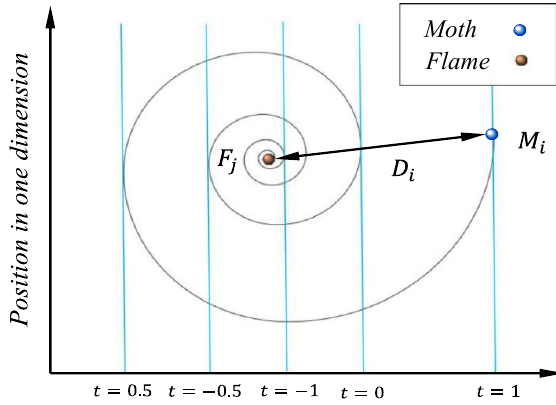
Figure 2. Geometric trajectory diagram of flying moth catching flame around logarithmic spiral curve.